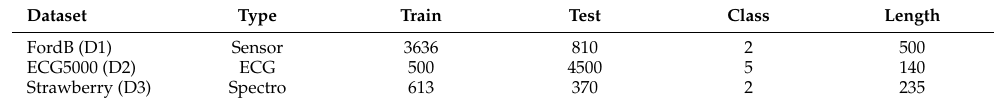
Table 1. Selected datasets from the 2018 UCR Time Series Classification Archive.